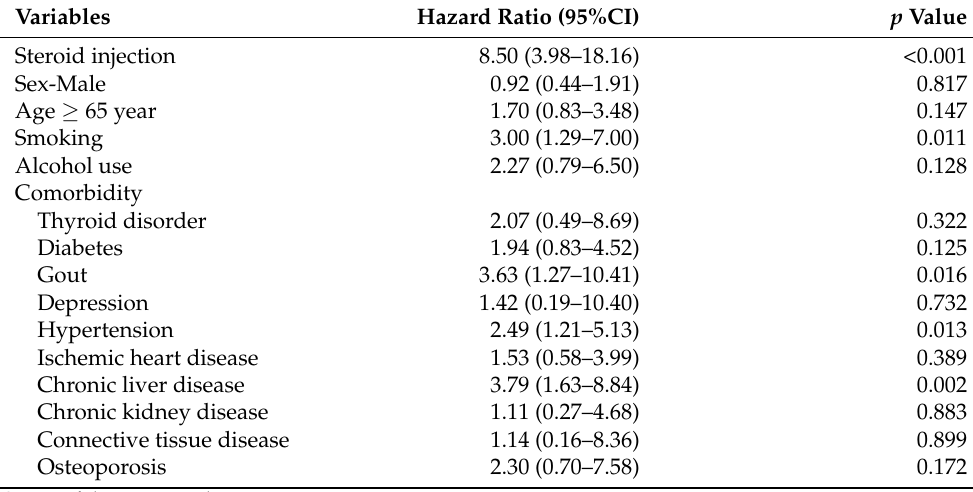
Table 2. Factors of outcomes after univariate Cox regression analysis.